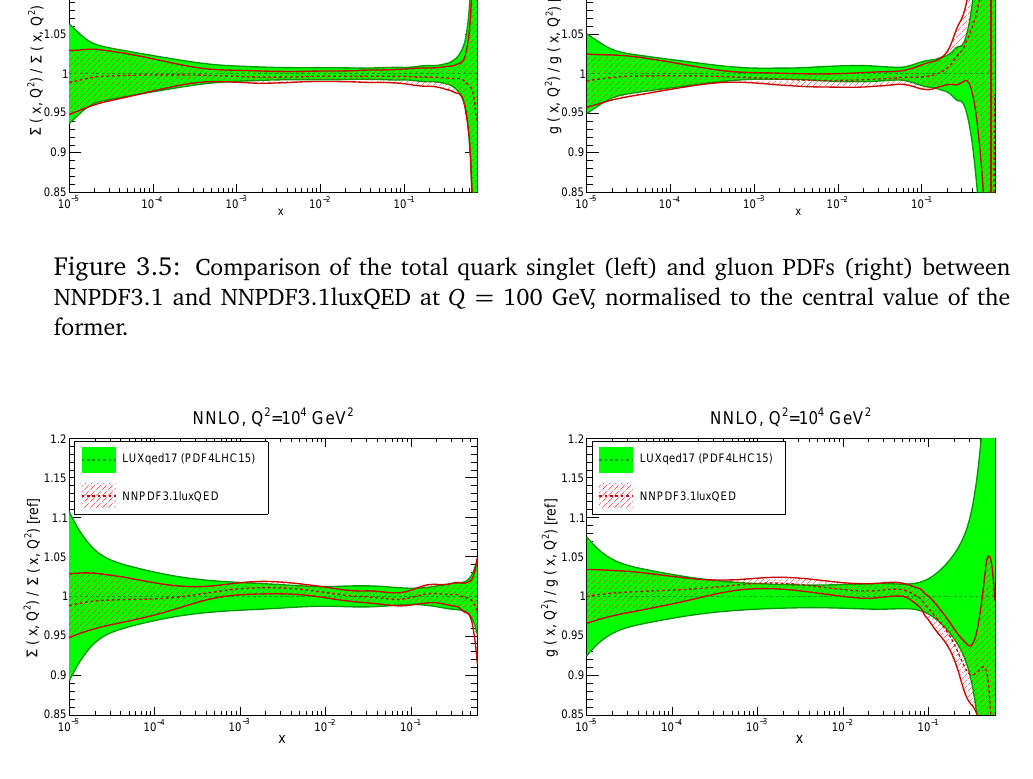
Figure 3.6: Same as Fig. 3.5, now comparing the quark singlet and gluon of NNPDF3.1luxQED with those of LUXqed17, which correspond closely to the PDF4LHC15 NNLO